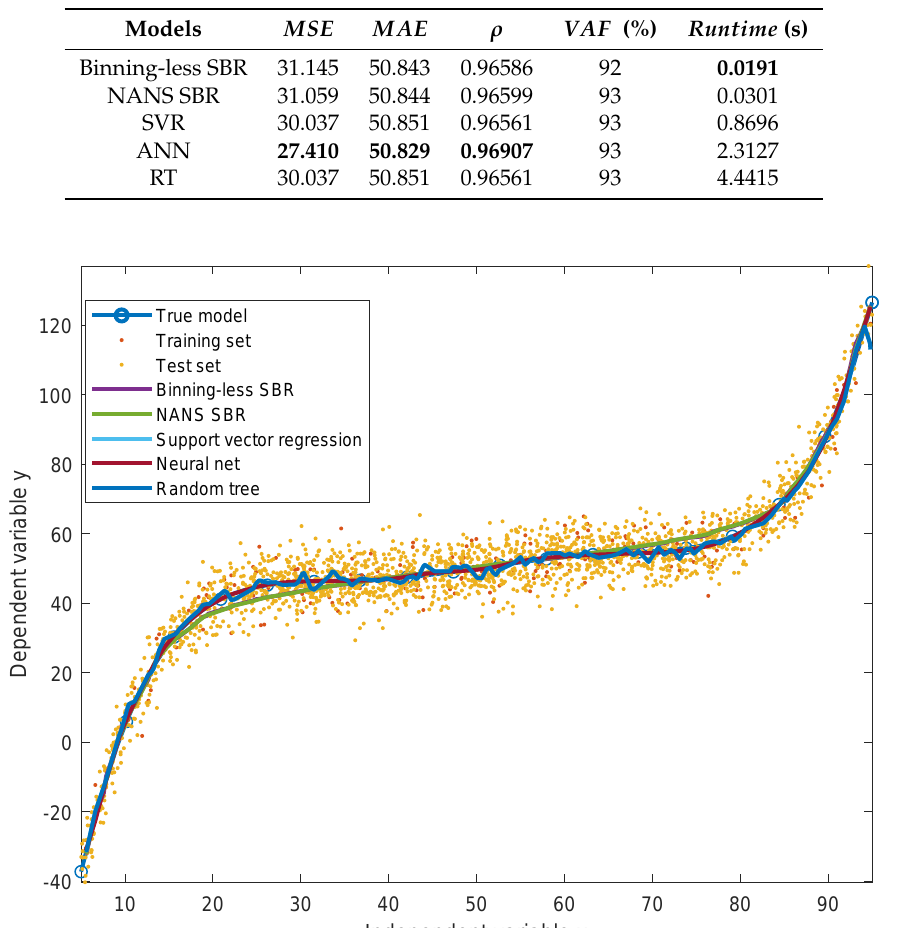
Figure 1. Comparison on modeling a polynomial dependency made using numerical-algebraic neural-system based statistical bivariate numerical modeling algorithm (NANS SBR), the proposed binning-less statistical bivariate numerical modeling algorithm, an artificial neural network, a support vector regression algorithm and random-trees